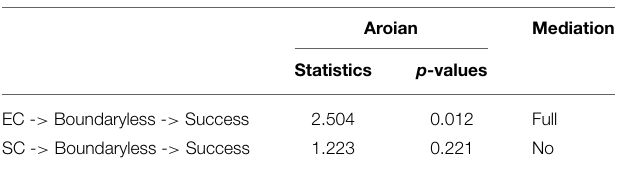
TABLE 7 | Mediation model.